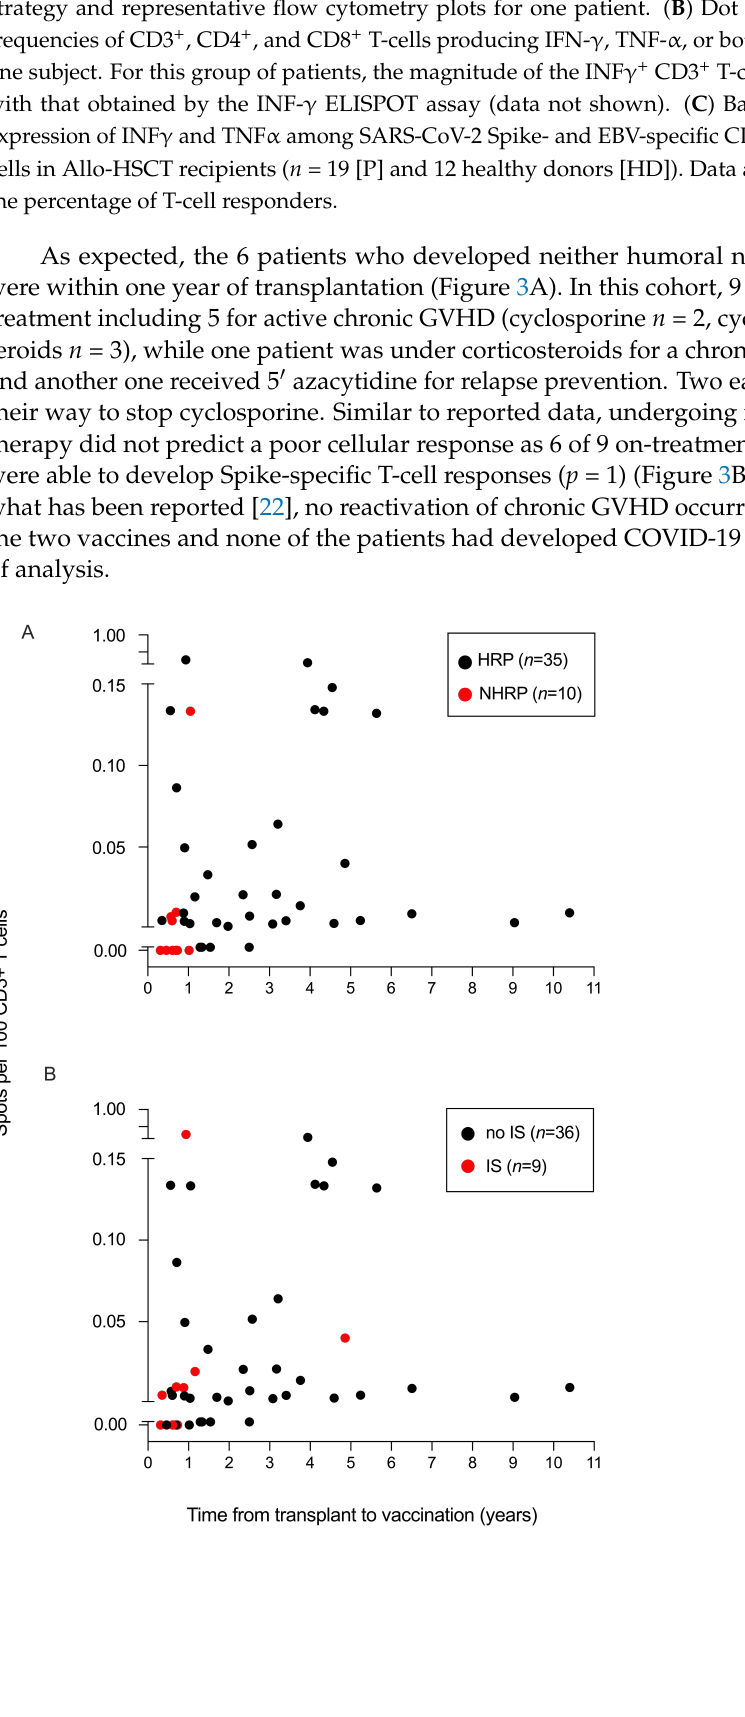
Figure 2. Features of specific CD3 + , CD4 + and CD8 + T-cell responses against SARS-CoV-2 Spike and EBV peptides according to INF γ and TNF α production in Allo-HSCT recipients ( n = 17: 2 NHRP, 15 HRP and 12 healthy donors (HD)) after two injections of BNT162b2 mRNA vaccine. PBMC were stimulated with Spike, EBV peptides, Cytostim (positive control) or not stimulated (NS). ( A ) Gating strategy and representative flow cytometry plots for one patient. ( B ) Dot plots representing the frequencies of CD3 + , CD4 + , and CD8 + T-cells producing IFN- γ , TNF- α , or both. Each dot represents one subject. For this group of patients, the magnitude of the INF γ + CD3 + T-cell response correlated with that obtained by the INF- γ ELISPOT assay (data not shown). ( C ) Bar graphs showing the expression of INF γ and TNF α among SARS-CoV-2 Spike- and EBV-specific CD3 + , CD4 + and CD8 + T cells in Allo-HSCT recipients ( n = 19 [P] and 12 healthy donors [HD]). Data are shown as means of the percentage of T-cell responders.